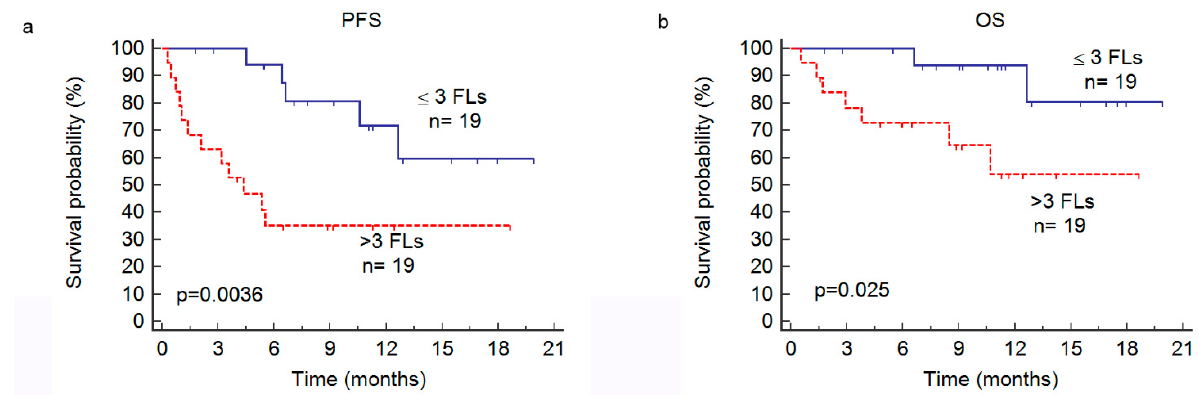
Figure 1. Kaplan–Meier estimates progression-free survival (PFS, a ) and overall survival (OS, b ) according to the presence of more than three focal lesions detected on PET (>3 FLs) or less/equal to three FLs ( ≤ 3 FLs).